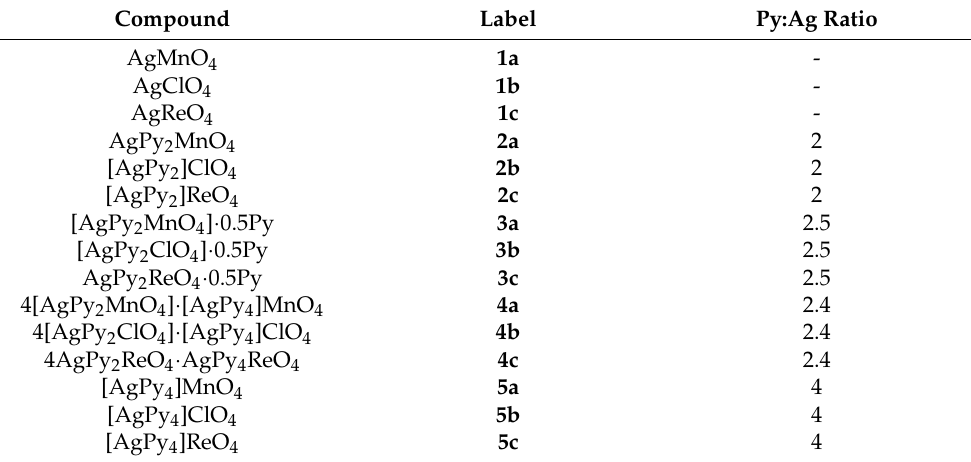
Table 1. Labels and Ag: Py ratios in pyridine complexes of AgXO 4 (X = Mn (a), Cl (b), and Re (c))